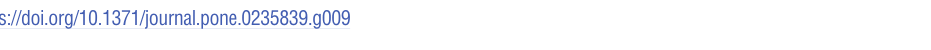
PLOS ONE | https://doi.org/10.1371/journal.pone.0235839 July 7,